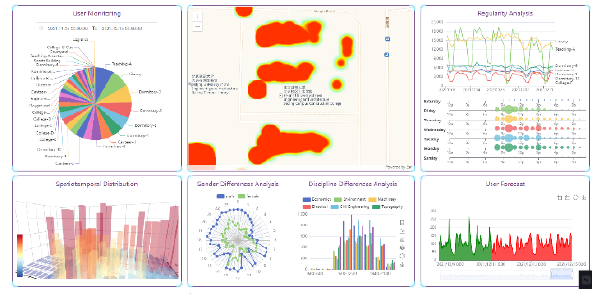
Figure 3 . System Overview.